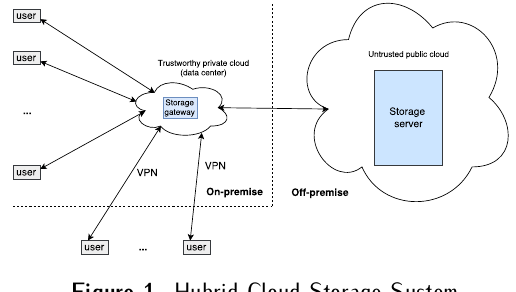
Figure 1. Hybrid Cloud Storage